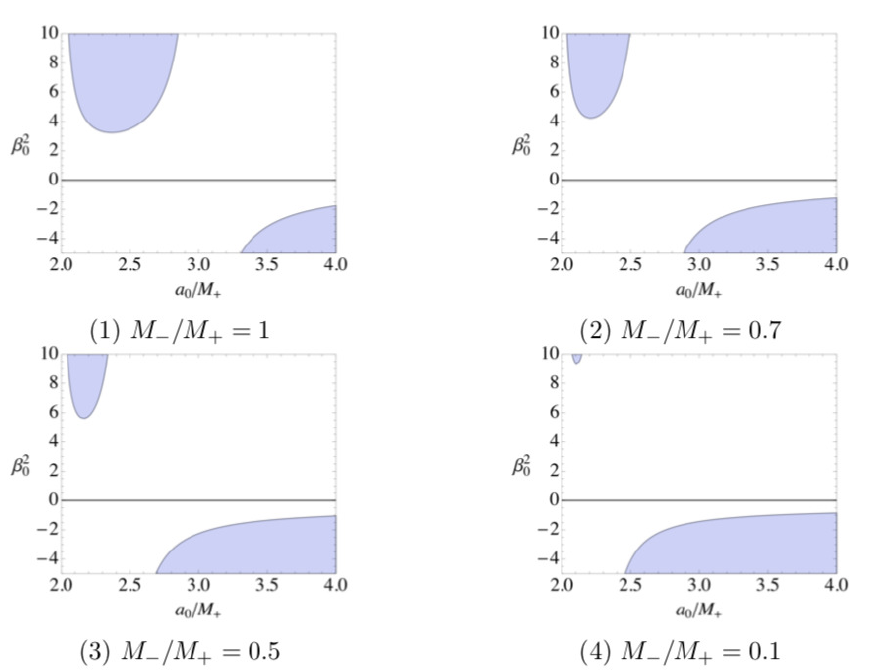
Figure 14. Non- Z 2 symmetry. The shaded regions represent stability. The area of stable regions decreases with increasing the difference between M + and M − . The horizontal axis is normalized by M + .